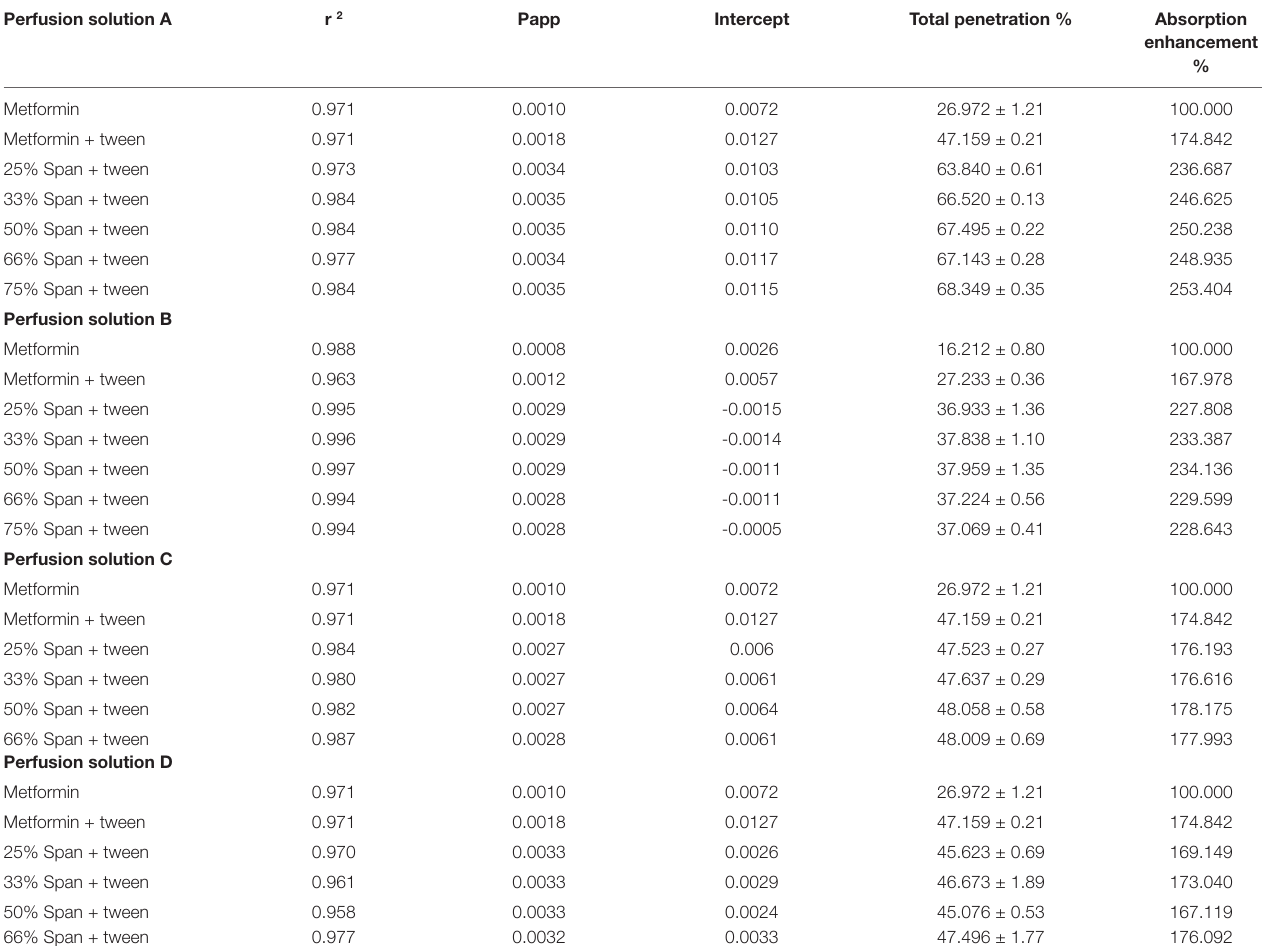
TABLE 5 | Data of metformin HCl Transferred through non-everted intestinal sac (Method